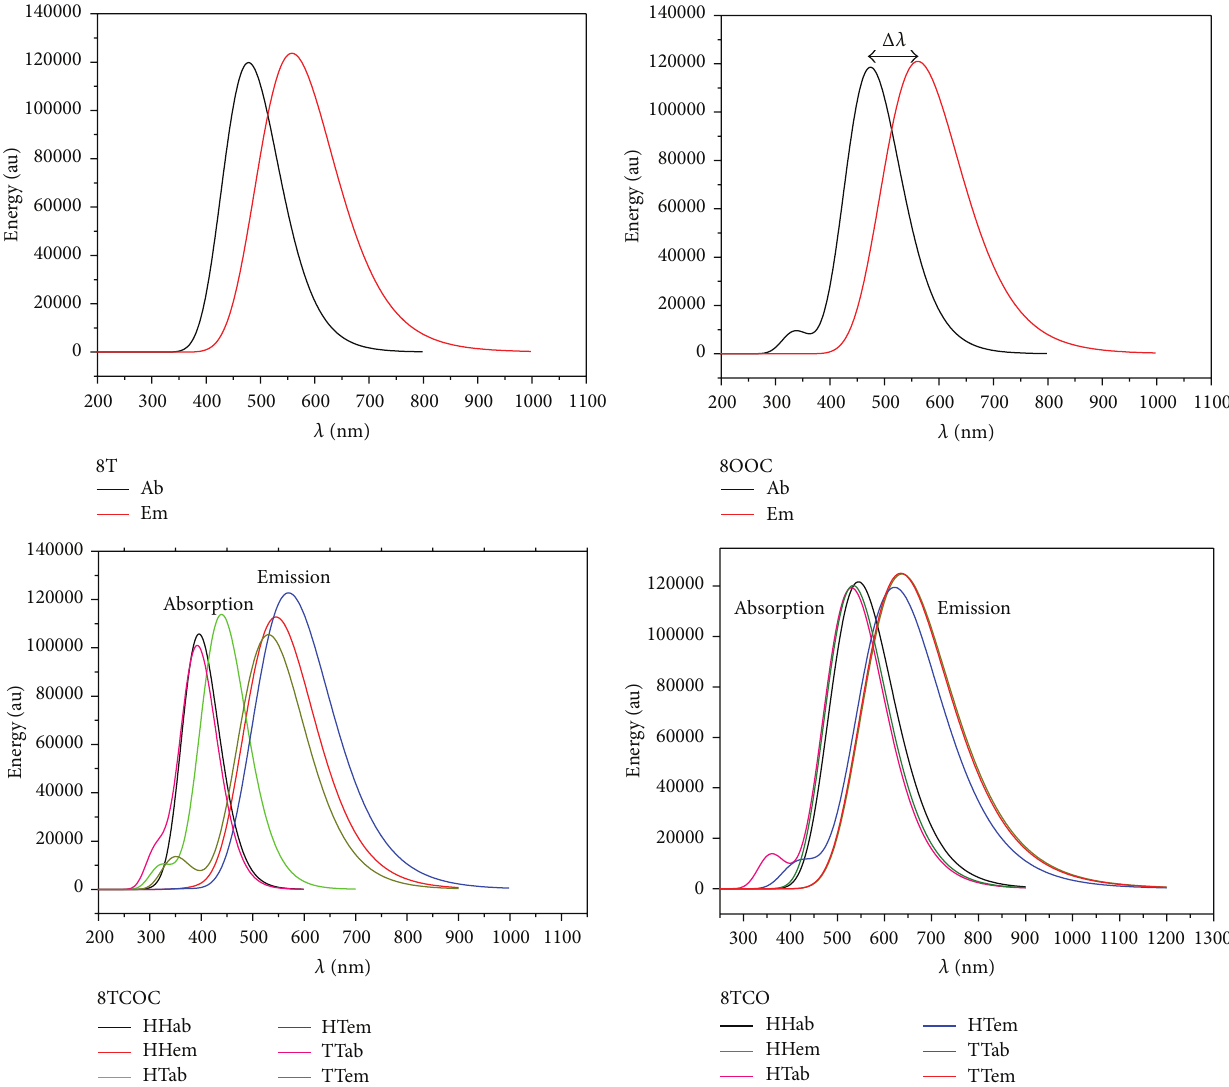
Figure 7: Calculated electronic absorption and emission of octamers units of 8T, 8TOC (HH, HT, and TT), 8TOOC, and 8TCOC (HH, HT, and TT) obtained by